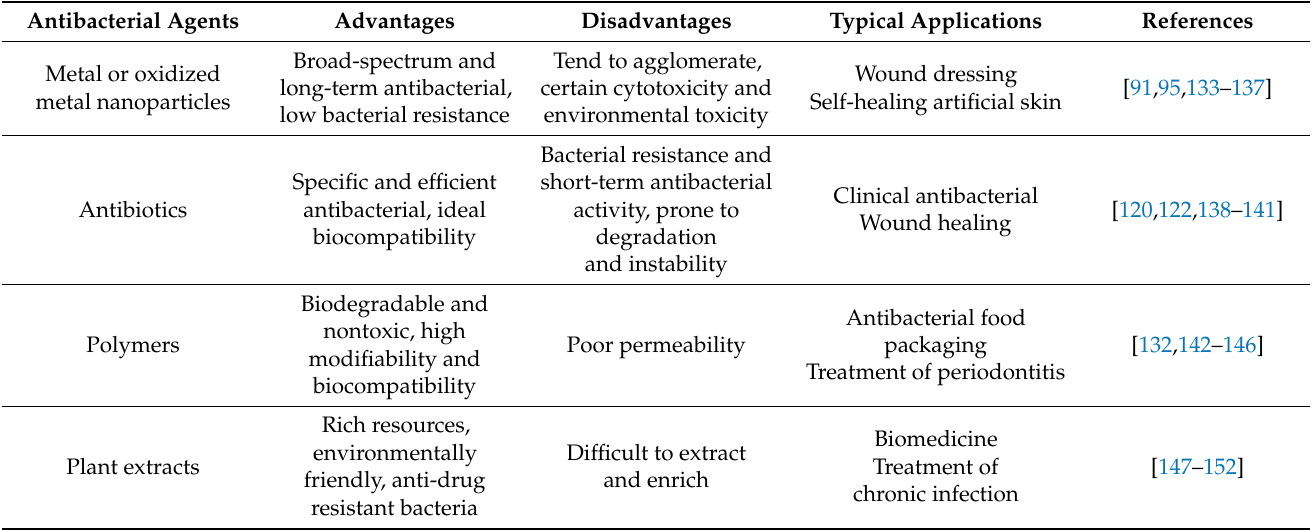
Table 3. The advantages and disadvantages of different antibacterial agents used to modify cellulose- based